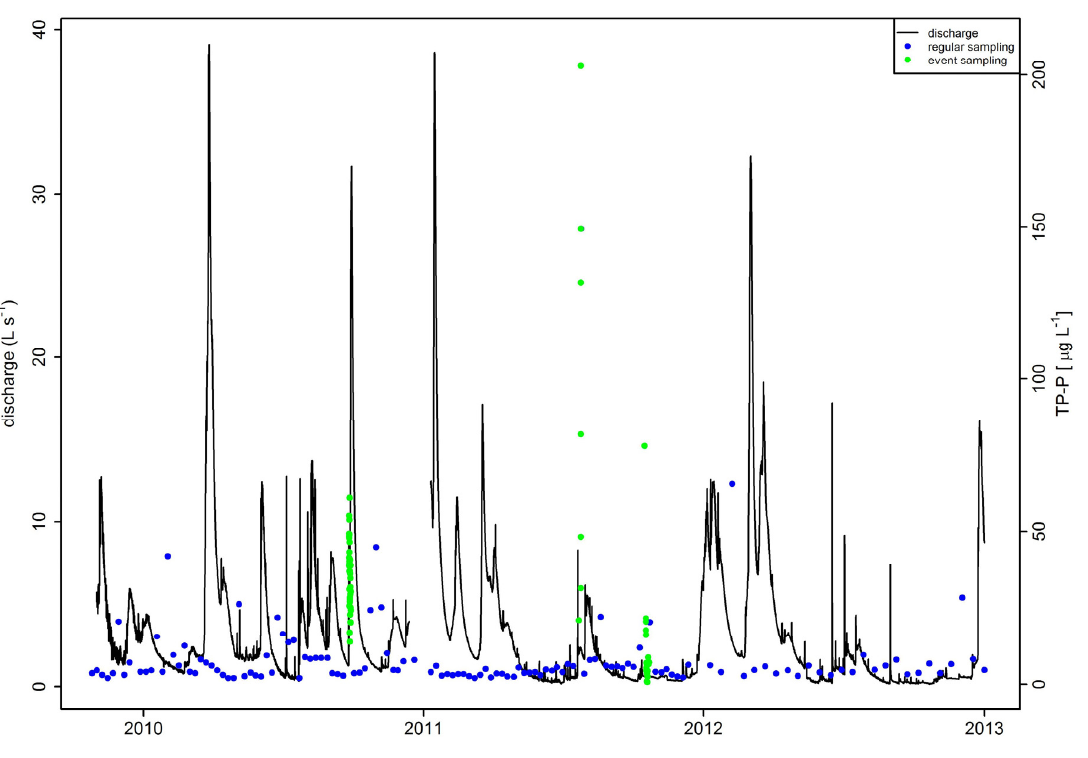
Figure 2. Time series of measured discharge (black line) and TP-P concentration for the fixed-schedule sampling (blue dots) and during the event sampling (green dots).